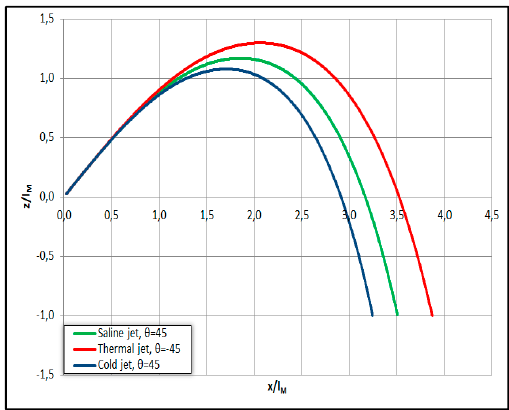
Figure 12. Comparison between negatively buoyant jets regarding their trajectory.